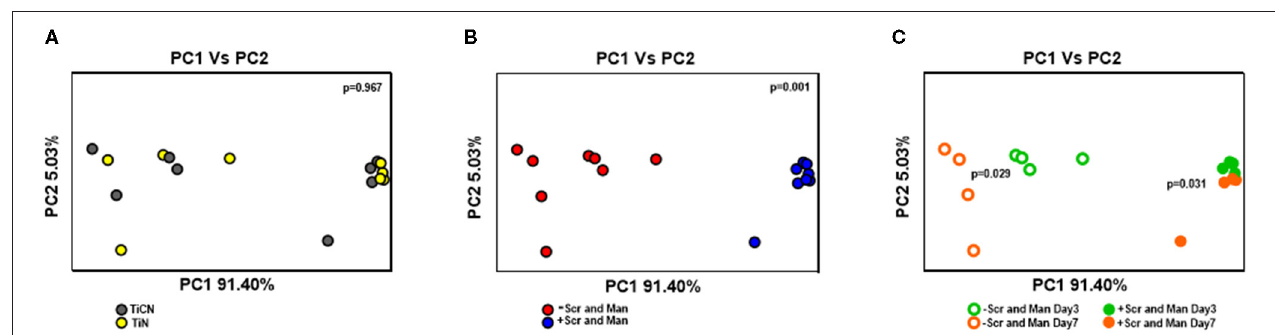
FIGURE 8 | Beta diversity analysis of oral microbial biofilm communities formed on TiCN and TiN coatings evaluated by weighted unifrac. Principal coordinate analysis (PCoA) is plotted according to (A) the type of coating: TiCN (gray circles) and TiN (yellow circles) (B) growth conditions: without Scr and Man (red circles); with Scr and Man (blue circles) and (C) both growth conditions and time points: without and with Scr and Man day3 (open green circles and closed green circles, respectively) and without Scr and Man day7 (open orange circles and closed orange circles, respectively). The p -values obtained by analysis with 999 permutations in ANOSIM are shown with in the